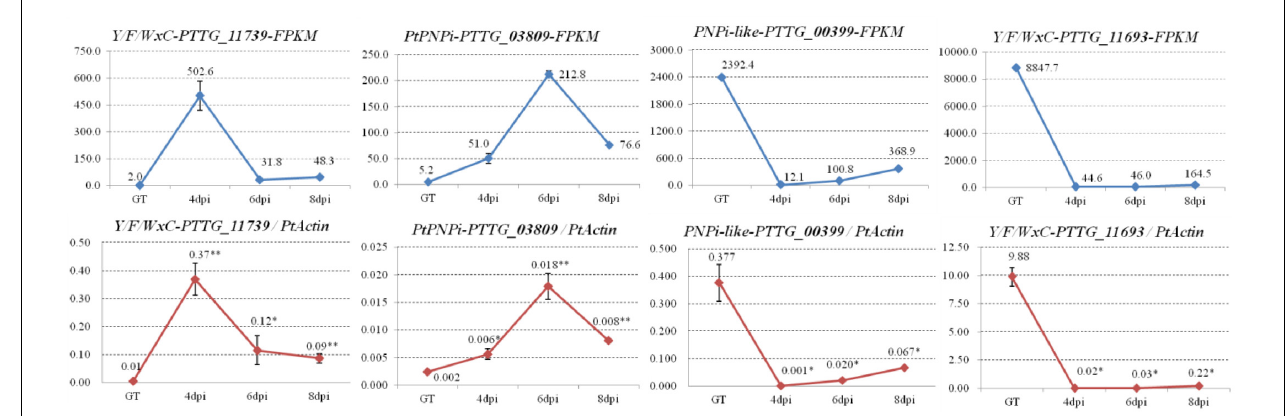
FIGURE 6 | The expression patterns of four selected effector candidates during Pt infection were validated by qRT-PCR assay. Four genes encoding effector candidates with different expression patterns were selected. Their expression patterns were generated based on corresponding FPKM values from the transcriptome database. The transcript levels of the four selected effector candidates during Pt infection at 4, 6, and 8 dpi were determined by qRT-PCR assay. Samples collected from the germ tubes (GT) of Pt uredospores served as a control. The transcript levels for all genes were expressed as linearized fold- PtActin levels, which were calculated according to the formula 2 ( ACTIN CT − TARGET CT ) . Data were expressed as mean values ± SE from four biological replicates. An asterisk (* P < 0.05, ** P < 0.01) indicates a significant difference between the control and infection samples by Dunnett’s test.